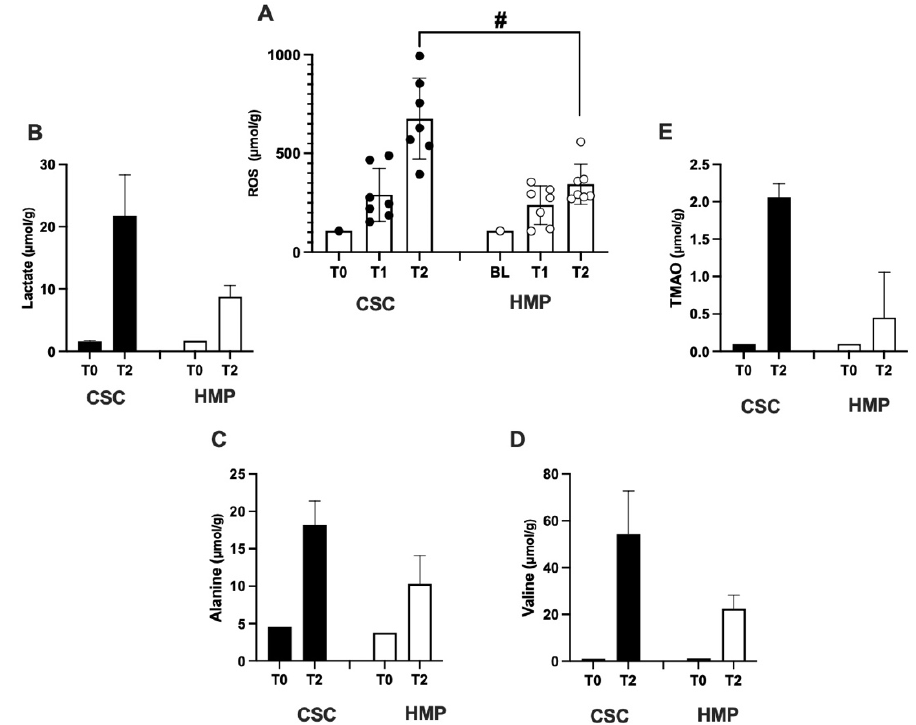
Figure 6. Histogram bars of: ( A ) ROS concentration ( μ mol/g) in kidney tissue at different experimental times: T0 (anesthesia), T1 (end of WI, 75min), and T2 (end of perfusion, 8 h) in SCS (full symbols) and HMP (empty symbols) groups. ( B – E ) metabolite concentration ( μ mol/g) calculated from 1 HNMR spectra collected on kidney tissue samples in SCS (full bars) and HMP (empty bars) groups at T0 and T2 experimental times. Significant difference # p < 0.01.